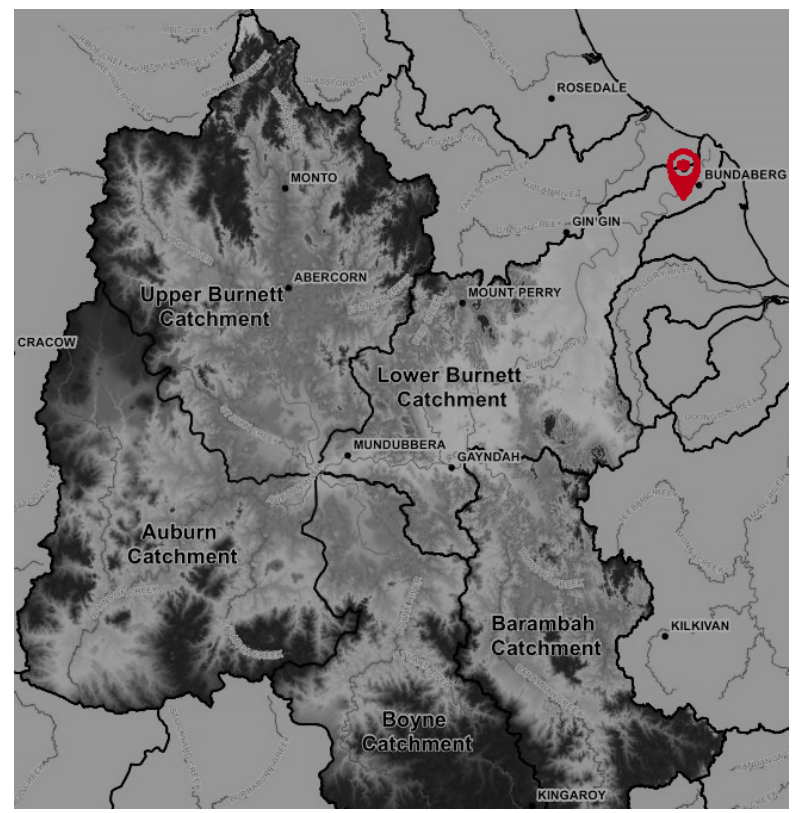
Figure 1. Burnett River catchment area and the monitoring site. This monitoring site is part of the Queensland Government’s water quality monitoring network